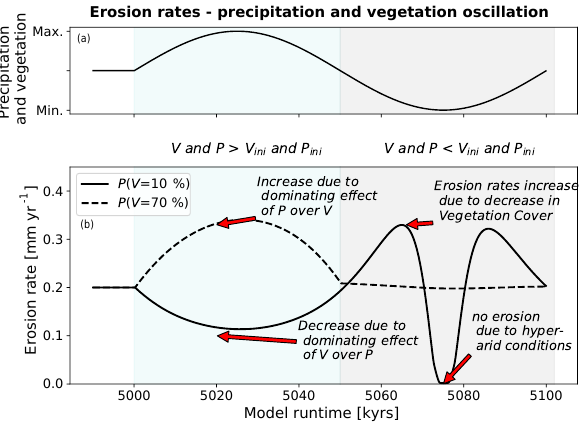
Figure 17. Mean catchment erosion rates for coupled simulations for one period of oscillation after the start of transient conditions (see also Fig. 15). Panel (a) shows conceptualized transient forcing in vegetation cover and mean annual precipitation. Panel (b) shows the erosion rates for simulations with low (black line) and high (dot- ted line) initial vegetation cover and precipitation